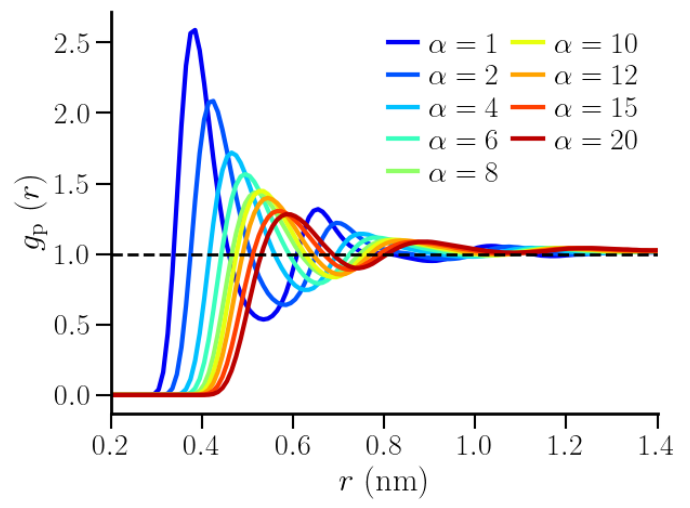
Figure 4. Proximal polymer-water RDFs for various strengths of repulsive interaction parameter α